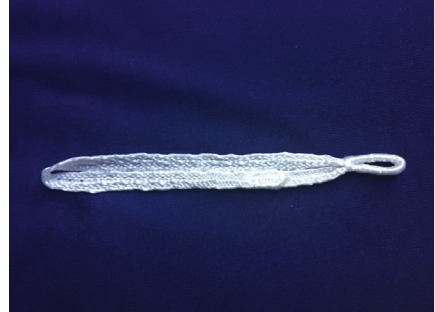
Figure 1: The lockdown